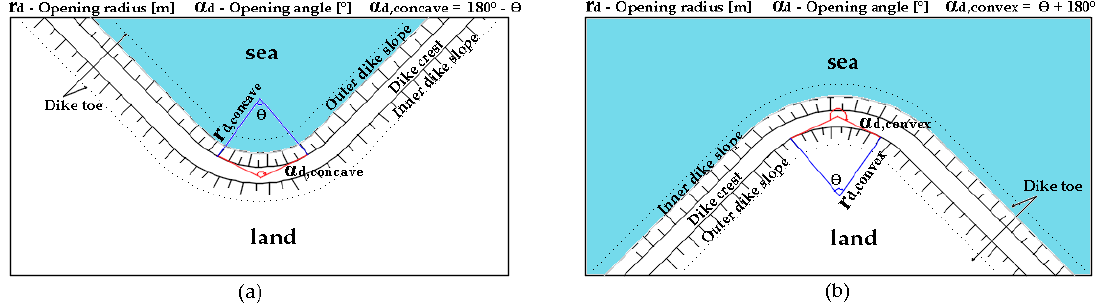
Figure 2. Definition sketch of opening angle, α d and opening radius, r d of curvatures in a dike line. ( a ) concave curvature ( b ) convex curvature.